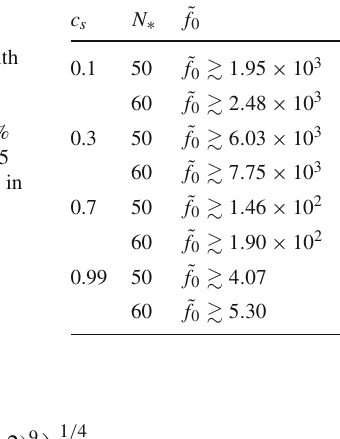
Fig. 2 The dn s / d ln k − n s diagram of the quartic potential (35) in the warmDBIinflationarysettingwith c s = 0 . 1.Thedashedandsolidlines correspond to N ∗ = 50 and N ∗ = 60, respectively. The marginalized joint 68% and 95% CL regions of Planck 2013, Planck 2015 TT + low P, and Planck 2015 TT, TE, EE + low P data [12] are specified by gray, red, and blue,